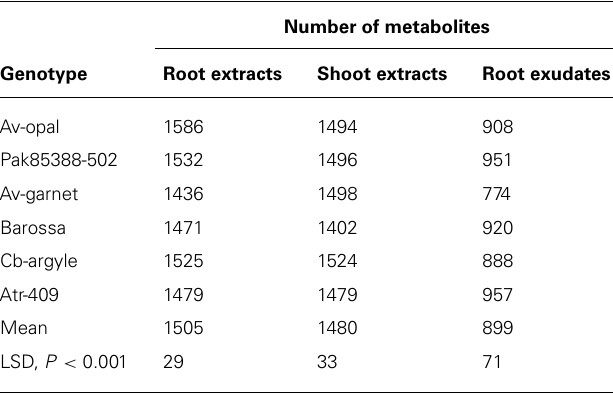
FIGURE 2 |The root length of canola ( Brassica napus ) and annual ryegrass ( Lolium rigidum ) seedlings when grown together in the ECAM bioassay. Data shown are means ( n = 30; ± SE) of the root length (mm) of annual ryegrass seedlings and of the root length (mm) of canola seedlings. Data were pooled of three experimental units (beakers).The cross indicates significant differences between the genotypes within one variable ( P < 0.05, ANOVA with post hoc Fisher-LSD-test).The Pearson correlation coefficient ( r ) is − 071 ( P > 0.05) and were determined between the two variables across all genotypes and the regression equation is y = 0.303x + 21.33, with R 2 = 0.50, P > 0.05). Table 2 |Total numbers of metabolites identified in root and shoot extracts and root exudates of six canola